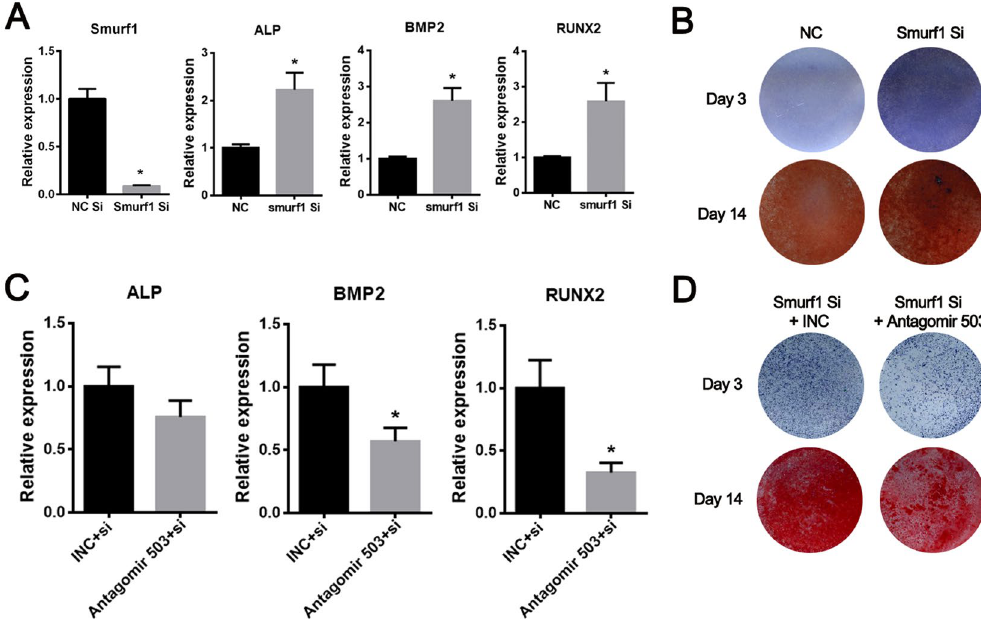
Figure 4. Smurf1 involves in miR-503 induced osteogenic differentiation in rBMSCs. ( A ) Expression level of smurf1 was significant down regulated after smurf1 siRNA transfection. Consequently, expression levels of ALP, BMP2 and Runx2 were increased by Smurf1 knockdown. ( B ) ALP and alizarin red staining were performed 3 days after Smurf1 siRNA transfection under osteogenic induction. Result showed that more ALP positive nodes and calcium nodes were observed in Smurf1 knockdown group. ( C,D ) The antagomir-503 reversed the upregulation of BMP2 and Runx2 induced by Smurf1 siRNA and it also reduced the promoted effect of Smurf1 knockdown on ALP & Alizarin Red staining. (n = 3, * P < 0.05).